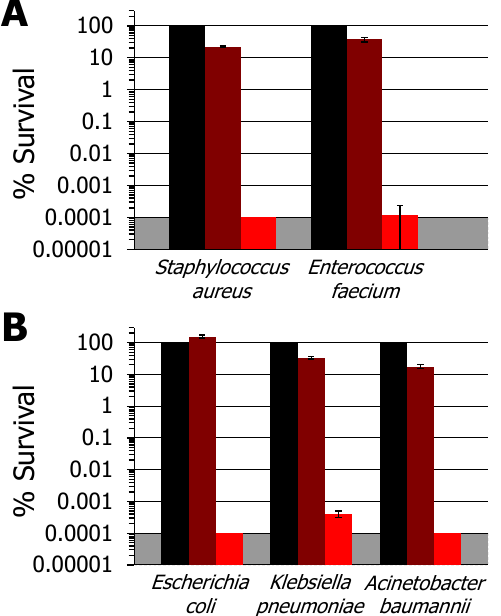
Figure 2. Photodynamic inactivation studies employing PAN-Por (+) . ( A ) Gram-positive species: methicillin-susceptible S. aureus (MSSA) ATCC-2913 and the vancomycin-resistant E. faecium (VRE) ATCC-2320 strain. ( B ) Gram-negative species: E. coli BL21-(Dε3)pLysS, K. pneumoniae ATCC-2146, and A. baumannii ATCC-19606. For both panels, displayed are the material-free (cells-only) dark control set to 100% (black), as well as the dark control of PAN-Por (+) (maroon) and the illuminated PAN-Por (+) (red) studies, both as the percent survival of the material-free (cells-only) dark control. For all bacteria, the illumination conditions were as follows: 30 min, 400–700 nm, 65 ± 5 mW/cm 2 (total fluence of 118 J/cm 2 ). As the plating technique employed to determine % survival did not allow for detection of survival rates of <0.0001%, data points below the detection limit were set to 0.0001% survival for graphing purposes and are indicated by the grey shaded area. In the cases where error bars cannot be visualized, the error bars themselves were smaller than the marker employed in the plot.